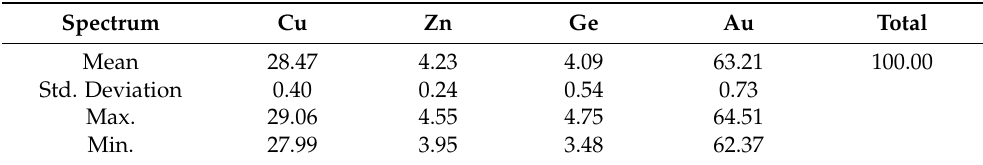
Table 2. Results of the micro-chemical EDS analysis: surface AuCuZnGe after corrosion testing (in